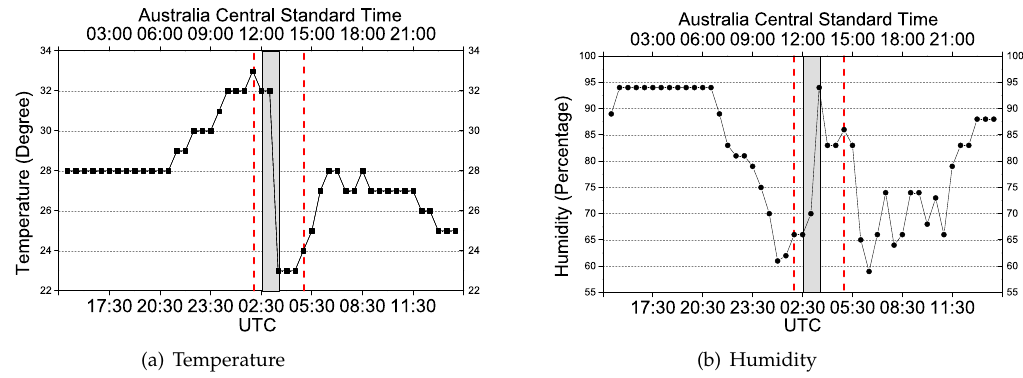
Figure 3. ( a ) Temperature and ( b ) humidity of the corresponding time period of Event 2.